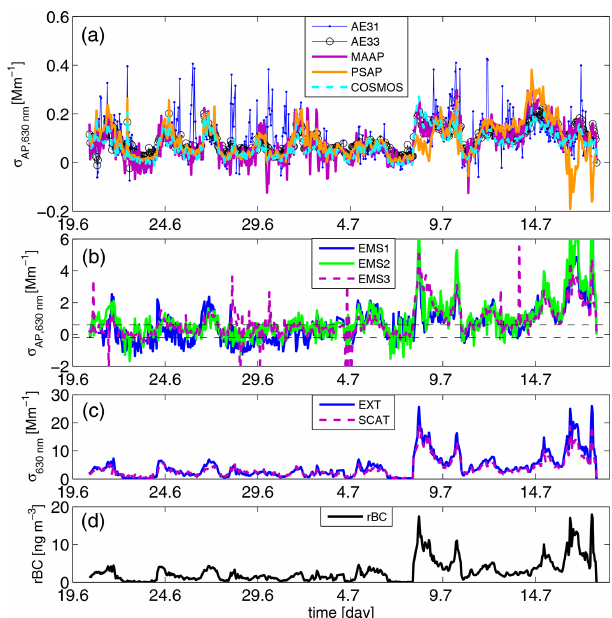
Figure 2. The 1h averaged absorption coefficients at λ = 630nm during the whole campaign period measured with (a) the filter- based instruments and (b) the EMS technique. To guide the eye, in (b) the lower and upper limits of (a) are also depicted with dashed black lines. Simultaneously measured extinction and scattering co- efficients and the residual-BC concentration are presented in (c, d) . The extinction and scattering presented were measured with AUR4 and CAPSssa instruments, and the rBC was measured with SP2.